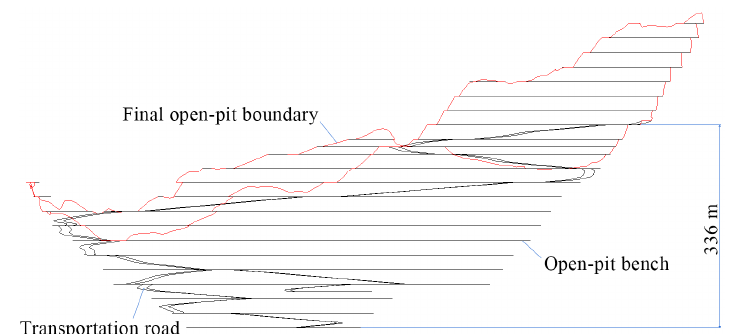
Figure 3. Schematic diagram of the calculated depth of the open ‐ pit.